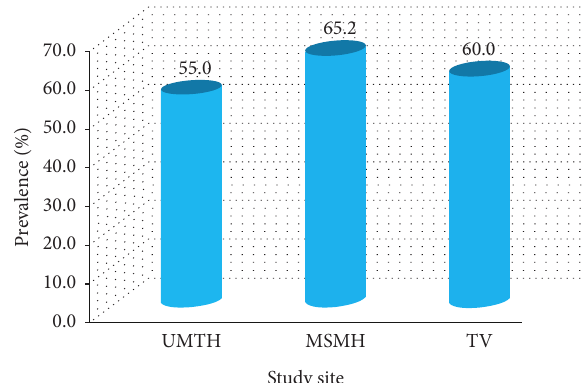
Figure 2: Study site distribution of triple Pfdhfr mutant alleles 51I, 59R, and 108N ( p > 0 . 05).